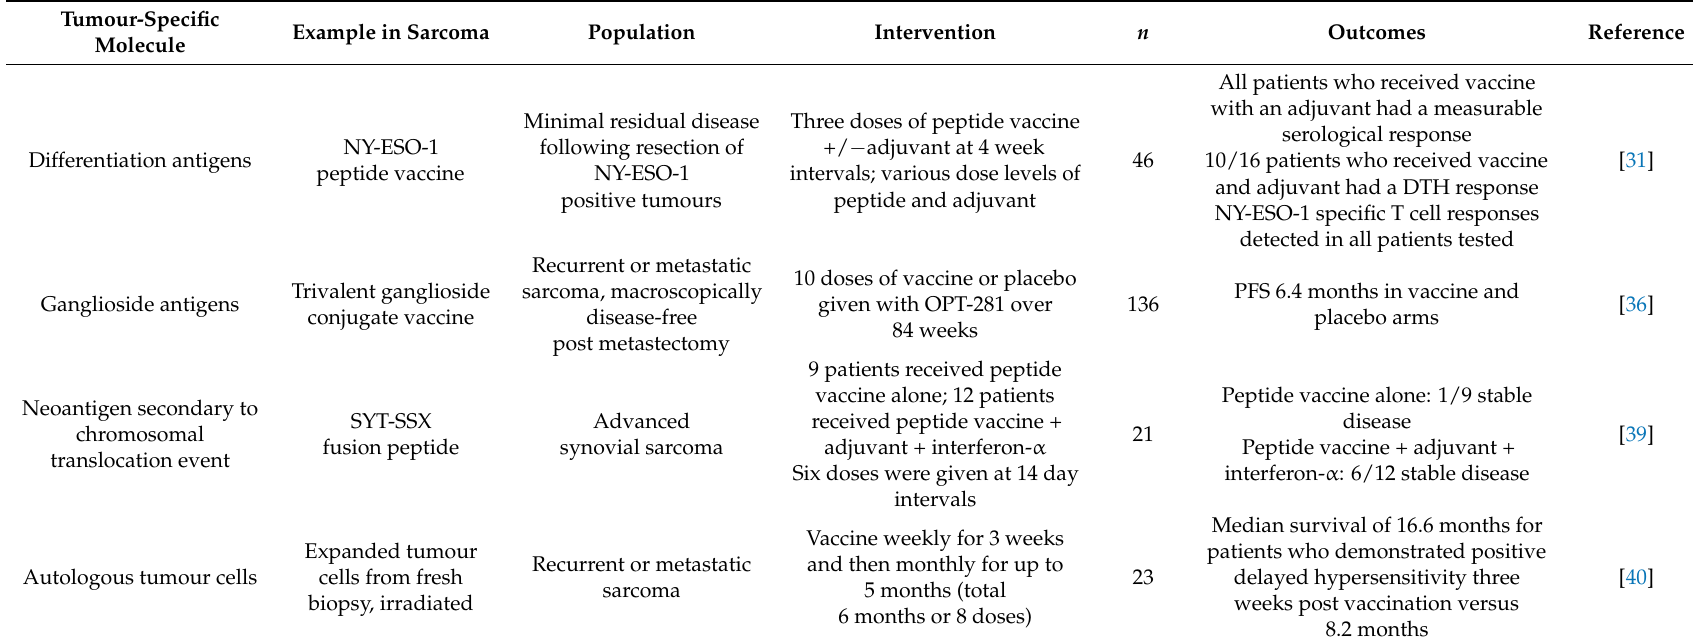
Table 1. Summary of vaccine trials in sarcoma using various tumour-specific target